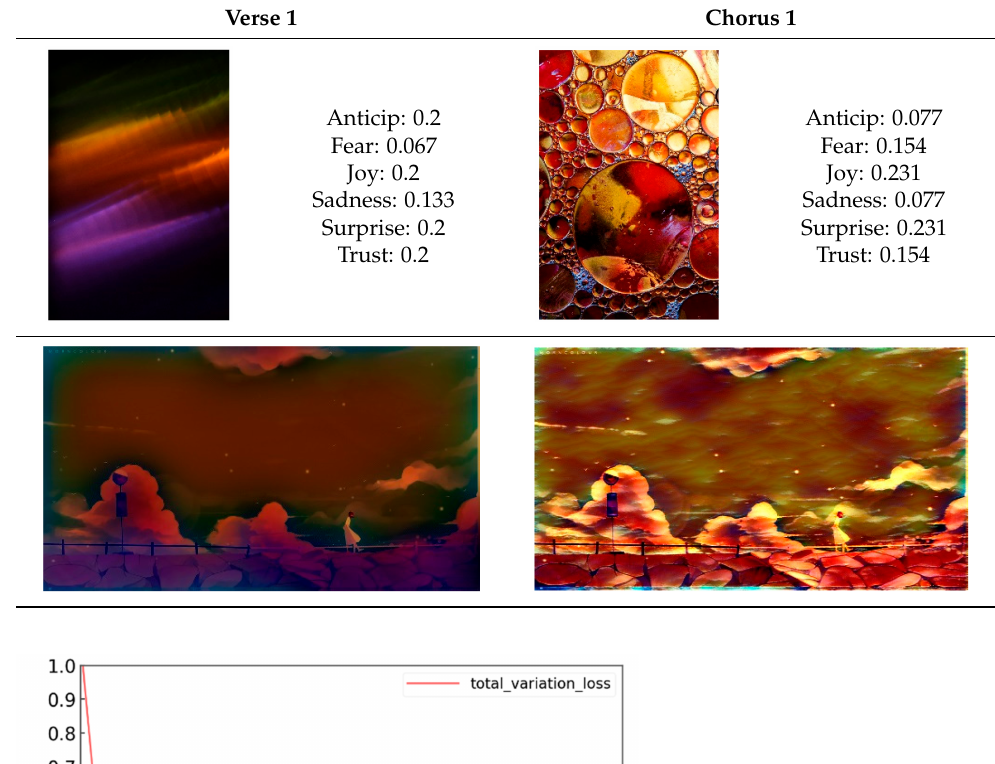
Table 4. Comparison of edges.